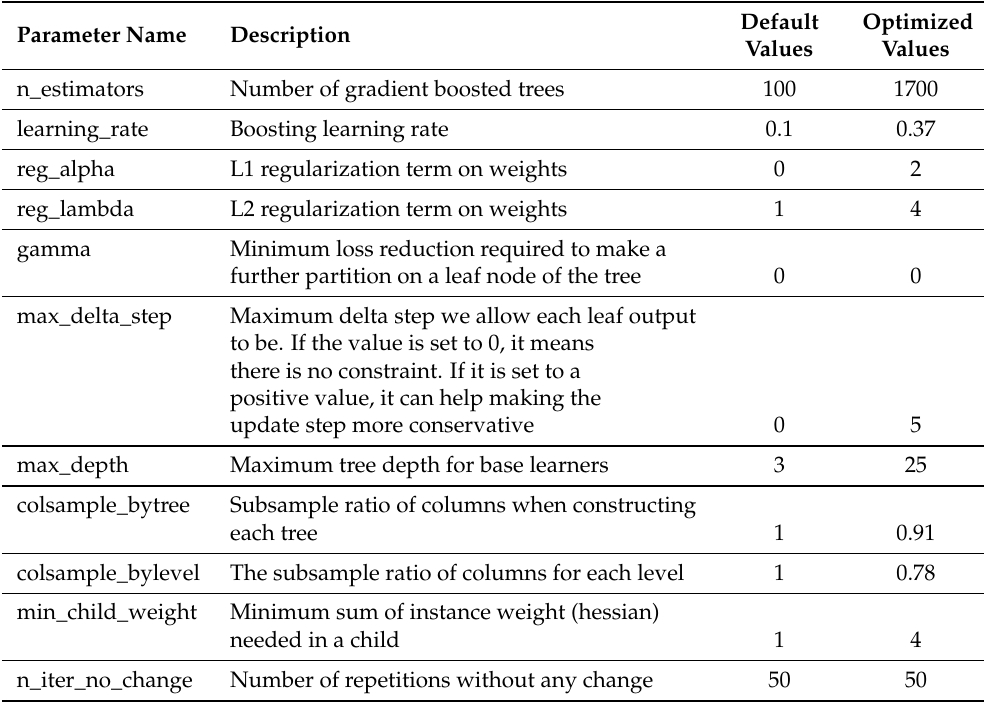
Figure 3. Optimization history of the XGboost classifier. Table 3. XGboost’s hyperparameters and its default and optimized